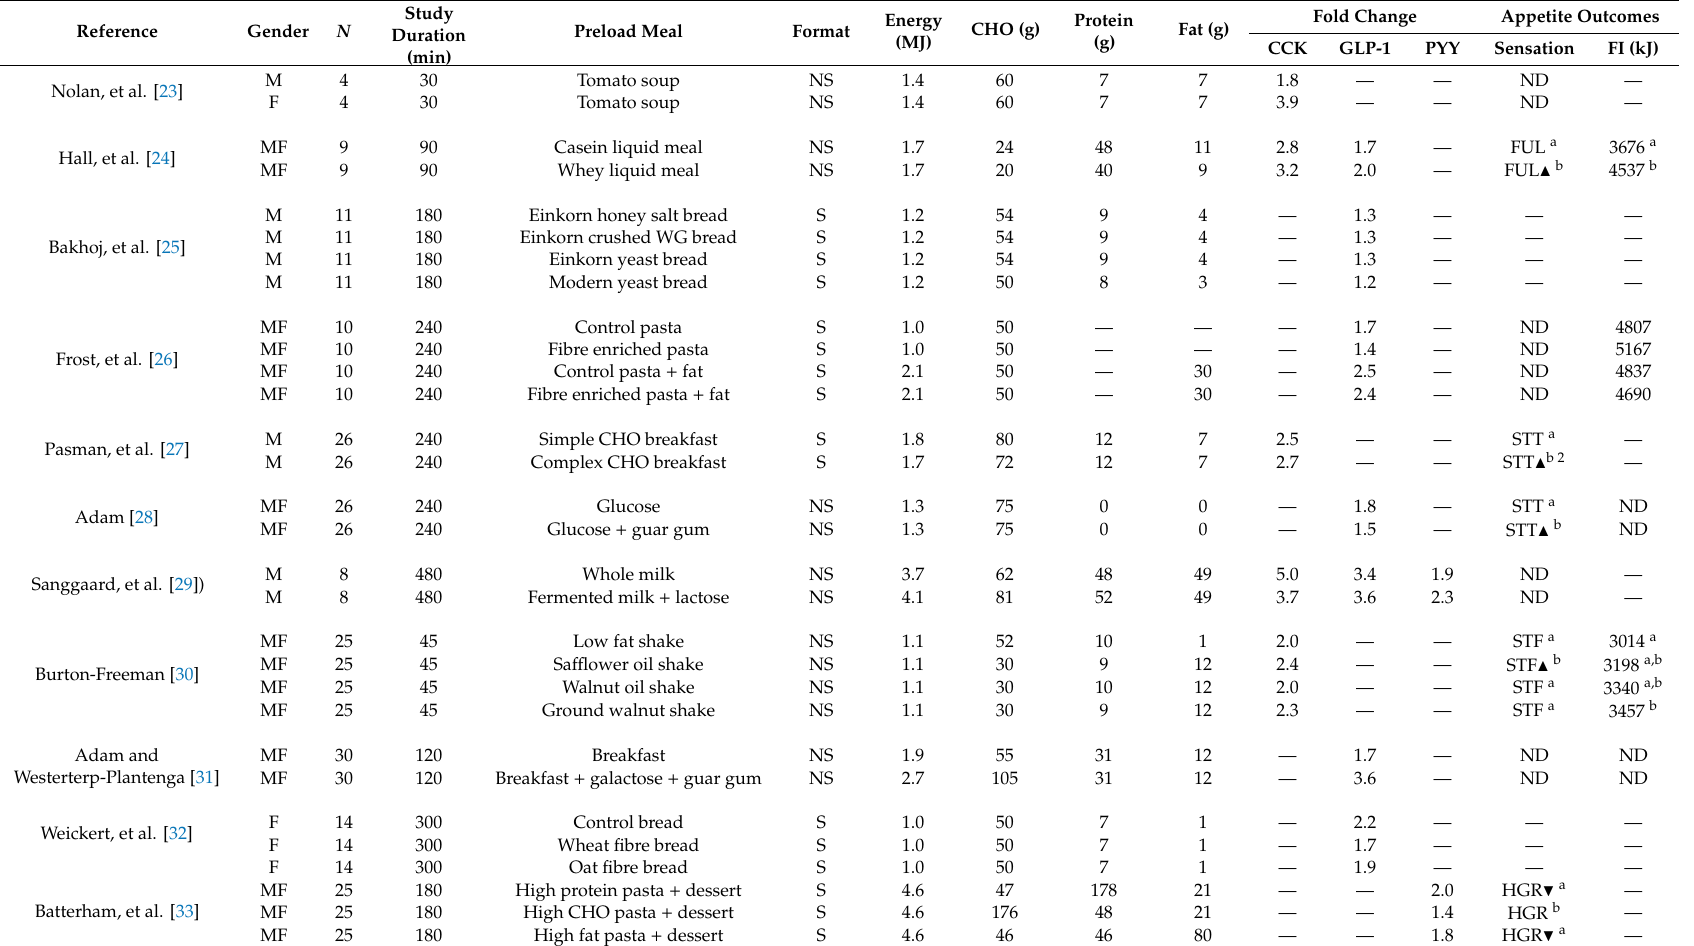
Table 1. Dietary preload (DIET) studies in lean men and